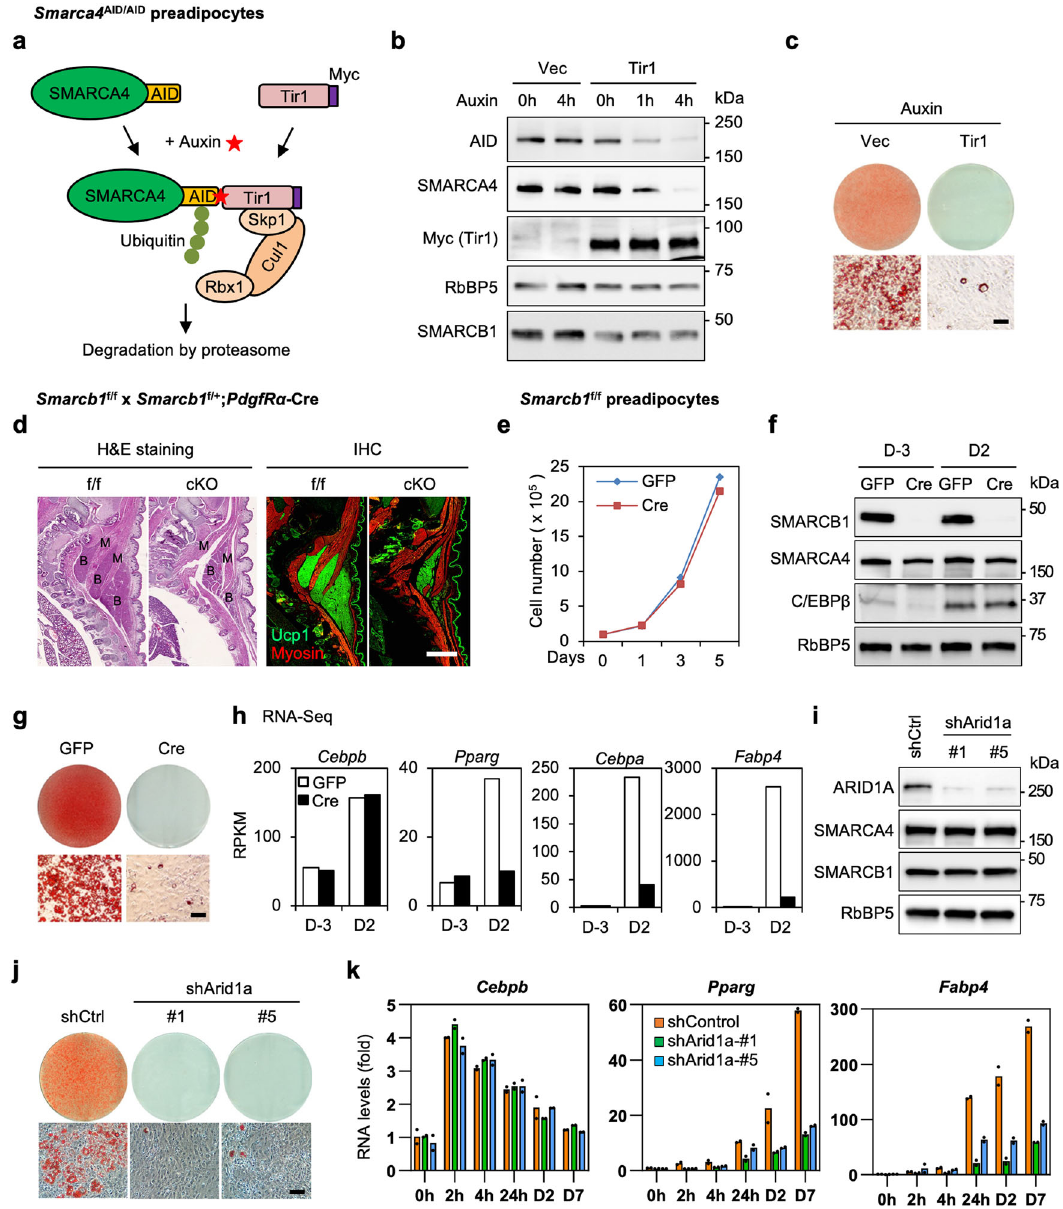
Fig. 2 BAF subunits SMARCA4, SMARCB1 and ARID1A are required for adipogenesis. a – c Depletion of SMARCA4 by auxin-inducible degron (AID) system inhibits adipogenesis. SV40T-immortalized Smarca4 AID/AID brown preadipocytes were infected with retroviruses expressing Tir1 or vector (Vec), and then treated with auxin for indicated times. a A schematic illustration of the auxin-induced depletion of endogenous SMARCA4 protein in Tir1- expressing Smarca4 AID/AID cells. TIR1, transport inhibitor response 1; Cul1, Cullin-1; Rbx1, RING-box protein 1; Skp1, S-phase kinase-associated protein 1. b Western blot analyses using antibodies indicated on the left. RbBP5 was used as a loading control. n = 3 biological replicates. c Oil Red O staining at day 7 (D7) of adipogenesis. Cells were treated with auxin throughout the differentiation. n = 2 biological replicates. Scale bar = 50 μ m. d SMARCB1 is essential for brown adipogenesis in vivo. Sections of the interscapular area of E18.5 Smarcb1 f/f (f/f) and Smarcb1 f/f ; PdgfR α -Cre (cKO) embryos were stained with H&E (left panels) or with antibodies recognizing brown adipose tissue (BAT) marker Ucp1 (green) and skeletal muscle marker Myosin (red) (right panels). B, BAT; M, muscle. Scale bar = 1 mm. n = 2 biological replicates. e – h SMARCB1 is essential for adipogenesis in culture. SV40T-immortalized Smarcb1 f/f brown preadipocytes were infected with adenoviral GFP or Cre, followed by adipogenesis assays. e Deletion of Smarcb1 does not affect cell growth rates of immortalized brown preadipocytes. 1 ×10 5 preadipocytes were plated and the cumulative cell numbers were determined for 5 days ( n = 2). Data are presented as mean values ± std. dev. f Before (D-3) and during (D2) adipogenesis, nuclear extracts were analyzed by Western blot using indicated antibodies. n = 2 biological replicates. g Oil Red O staining at D7 of adipogenesis. n = 3 biological replicates. Scale bar = 50 μ m. h Expression of Cebpb , Pparg , Cebpa and Fabp4 before (D-3) and during (D2) adipogenesis was determined using RNA-Seq ( n = 1). RPKM values indicate gene expression levels. i – k ARID1A is required for adipogenesis in culture. Immortalized Smarcb1 f/f brown preadipocytes were infected with lentiviral vectors expressing control (shCtrl) or Arid1a knockdown shRNA (shArid1a), followed by adipogenesis assays. i Western blot analysis of ARID1A in preadipocytes. n = 2 biological replicates. j Oil Red O staining at D7 of adipogenesis. n = 3 biological replicates. Scale bar = 50 μ m. k qRT-PCR analysis of Cebpb , Pparg , and Fabp4 expression at indicated time points of adipogenesis. Expression levels were normalized to 18 S rRNA . n = 2 biologically independent samples. Data are presented as mean values ± std. dev.